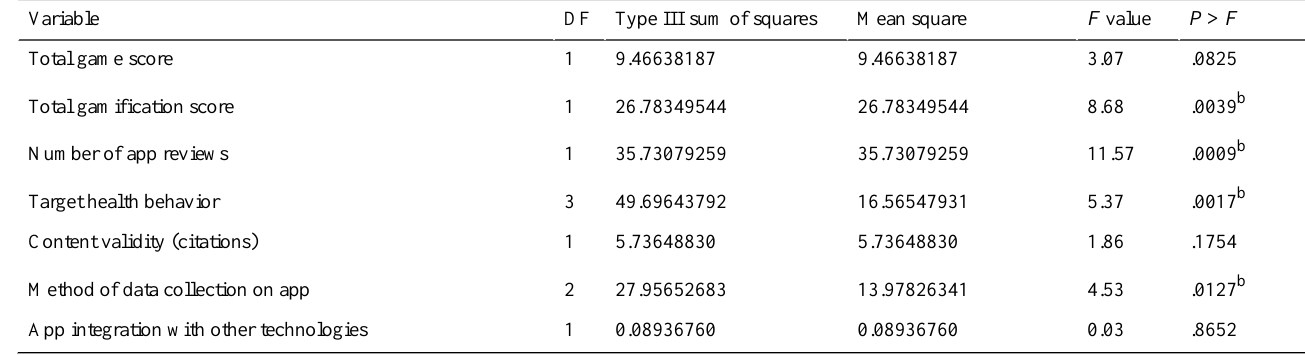
Table 6. Regression analysis, for total behavioral constructs (N=132). a